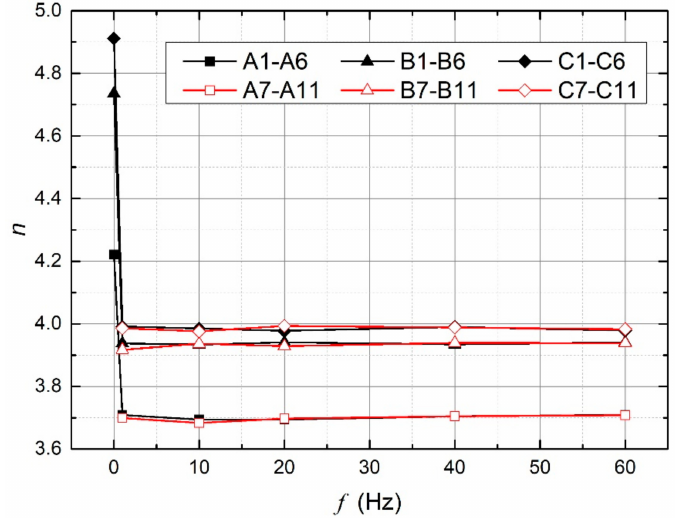
Figure 13. Overall n under computational cases with di ff erent